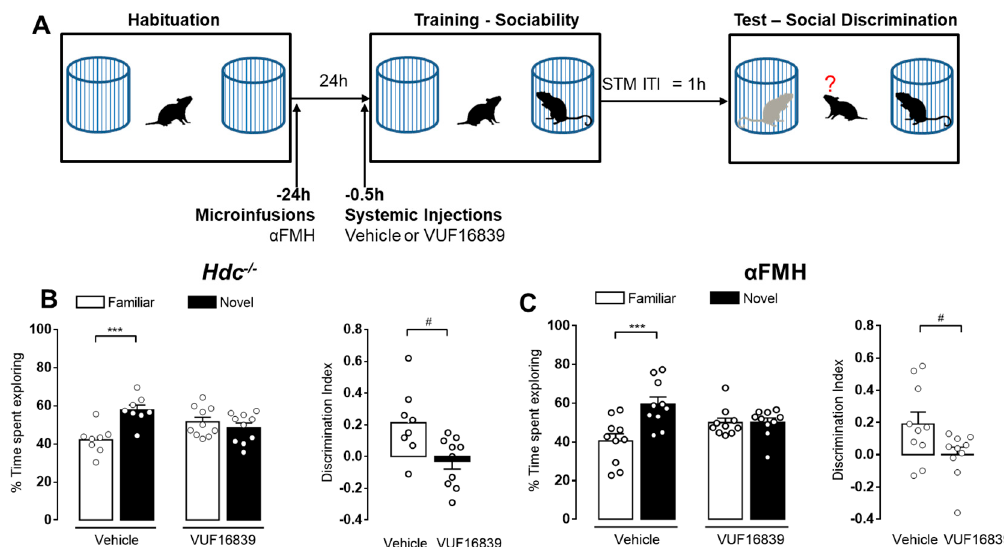
Figure 4. Activation of the H 3 R impairs consolidation and retrieval of long-term social recognition memory. ( A ) Schematic drawing showing the sequence of the behavioral procedures. VUF16839 (5 mg/kg, i.p.) or vehicle were injected to Hdc +/+ male immediately ( B ) or 23.5 h after ( C ) training. Retention tests were performed 24 h after training. Shown are means ± S.E.M. of 6–10 animals per experimental group. **** p < 0.0001, ** p < 0.01 by two-way ANOVA and Bonferroni’s MCT; ## p < 0.01, # p < 0.05 by unpaired t -test.